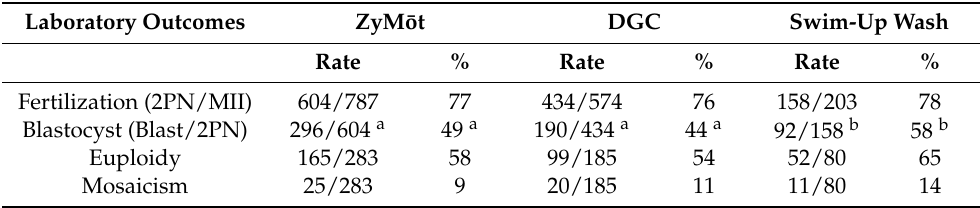
Table 2. Comparison of ZyM¯ot treatment and control processing methods density gradient centrifu- gation (DGC) and swim-up wash in embryo development